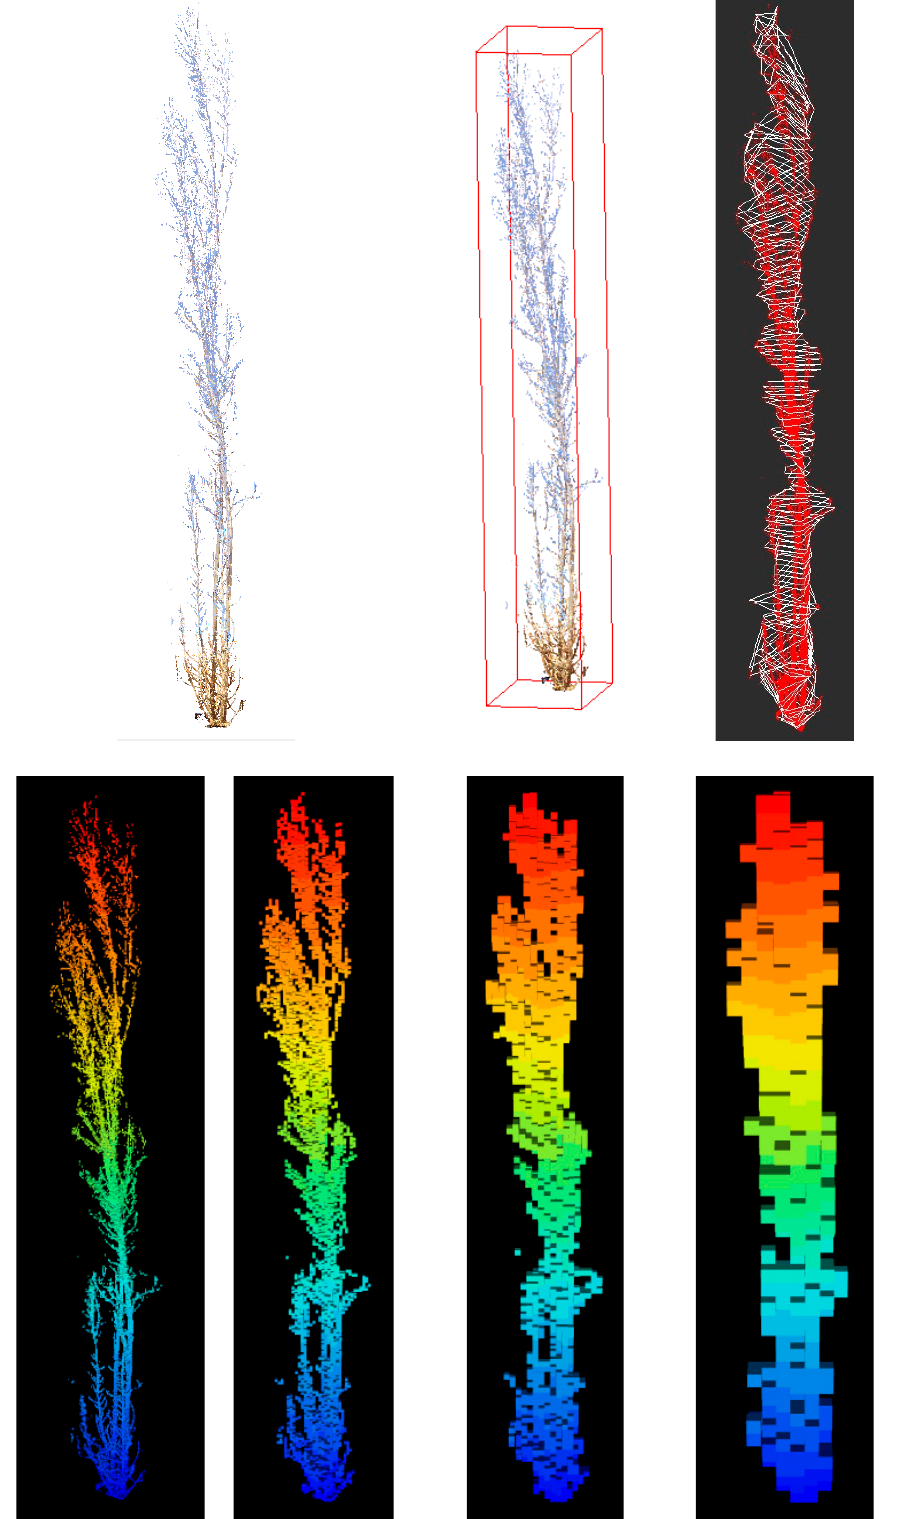
Figure 4. Representation of the three algorithms used to derive stool volume from TLS data. From left to right and top to bottom: picture of the scanned stool; bounding vox; slices; and voxels (2 cm, 5 cm, 10 cm, and 25 cm).